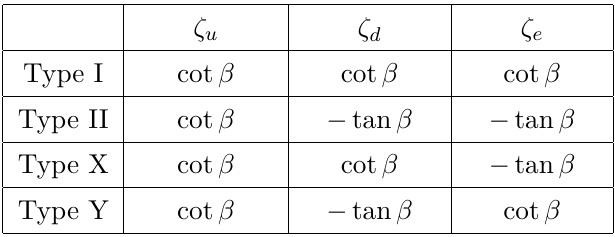
Table 1 . The values of ζ f ( f = u, d, e ) in each type of Yukawa